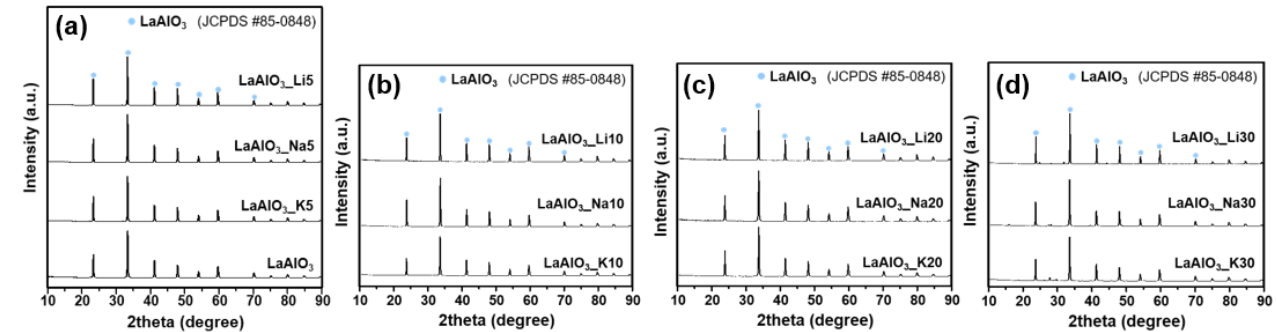
Figure 1. X-ray diffraction (XRD) patterns of the prepared LaAlO 3 _XY (X = Li, Na, K, Y = mol %) and LaAlO 3 catalysts: ( a ) LaAlO 3 _X5, ( b ) LaAlO 3 _X10, ( c ) LaAlO 3 _X20, and ( d ) LaAlO 3 _X30.